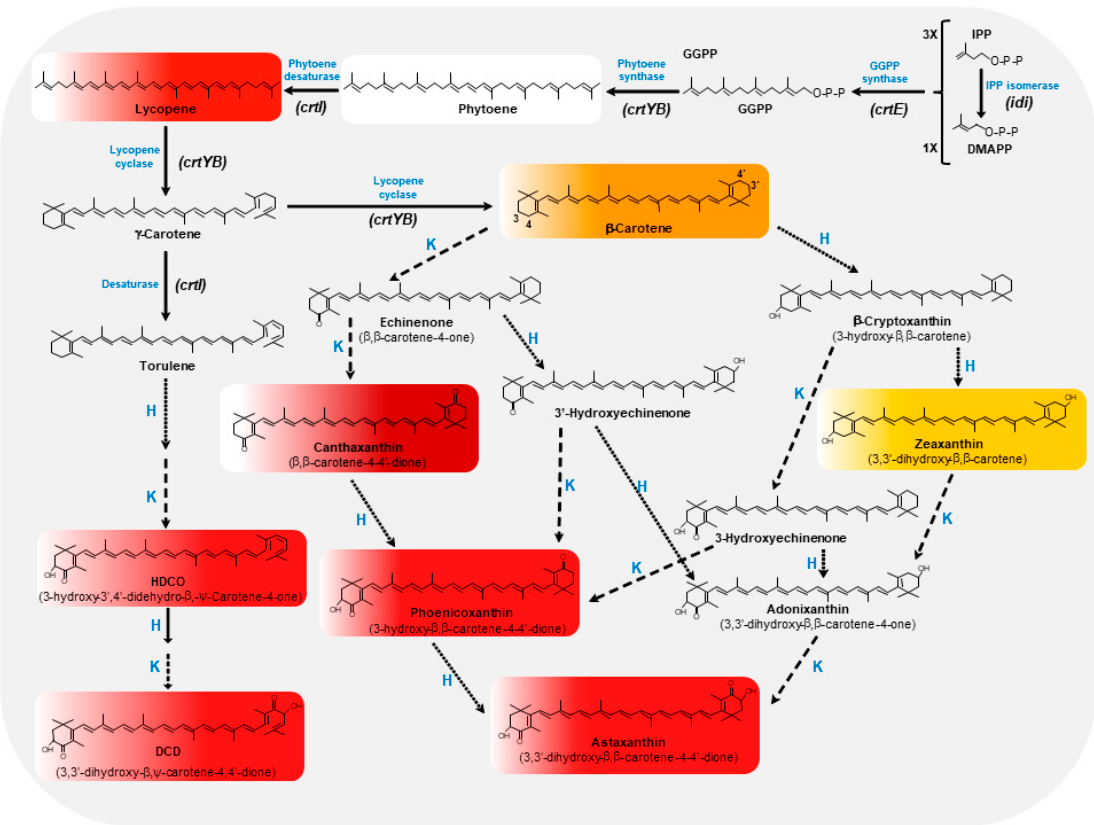
Figure 1. Astaxanthin biosynthetic pathway in X. dendrorhous . Initially, a molecule of dimethylallyl pyrophosphate (DMAPP) and three molecules of isopentenyl pyrophosphate (IPP) are combined to obtain geranylgeranyl pyrophosphate (GGPP) by means of the GGPP synthase. Secondly, two molecules of GGPP are coupled by the phytoene synthase ( crtYB gene) to reach phytoene. The phytoene desaturase( crtI gene) introduces four double bonds in the molecule of phytoene to to obtain lycopene. Then, the lycopene cyclase ( crtYB gene) converts one of the ψ acyclic ends of lycopene as β -ring to form γ -carotene, and subsequently the other to form β -carotene. Xanthophylls bioconversion in X. dendrorhous from β -carotene and γ -carotene includes the addition of two 4-keto groups in the molecule of β -carotene by the ketolase (K, discontinuous line) activity, and the inclusion of two 3-hydroxy groups by the hydroxylase (H, continuous dotted line) activity. Both K and H activities are presented in a single enzyme (astaxanthin synthetase; CrtS) encoded by a single gene ( crtS ). The cytochrome P450 reductase encoded by the crtR gene is a CrtS helper protein, providing with electrons for substrate oxygenation. The existence of a monocyclic pathway to DCD was also proposed [42]. Main carotenoids detected in X. dendrorhous broths are shown inside a rectangle in concordance with their natural colours. This figure has been based on Rodríguez-Sáiz and co-workers [43].